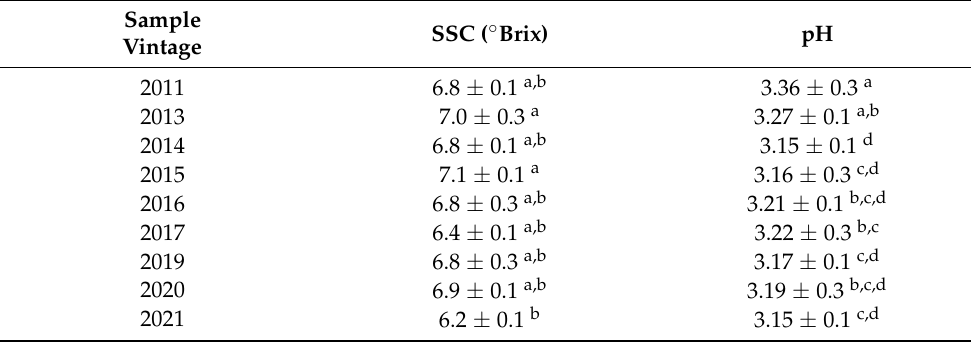
Table 2. SSC and pH values for Grillo wine samples in the period of 2011–2021.